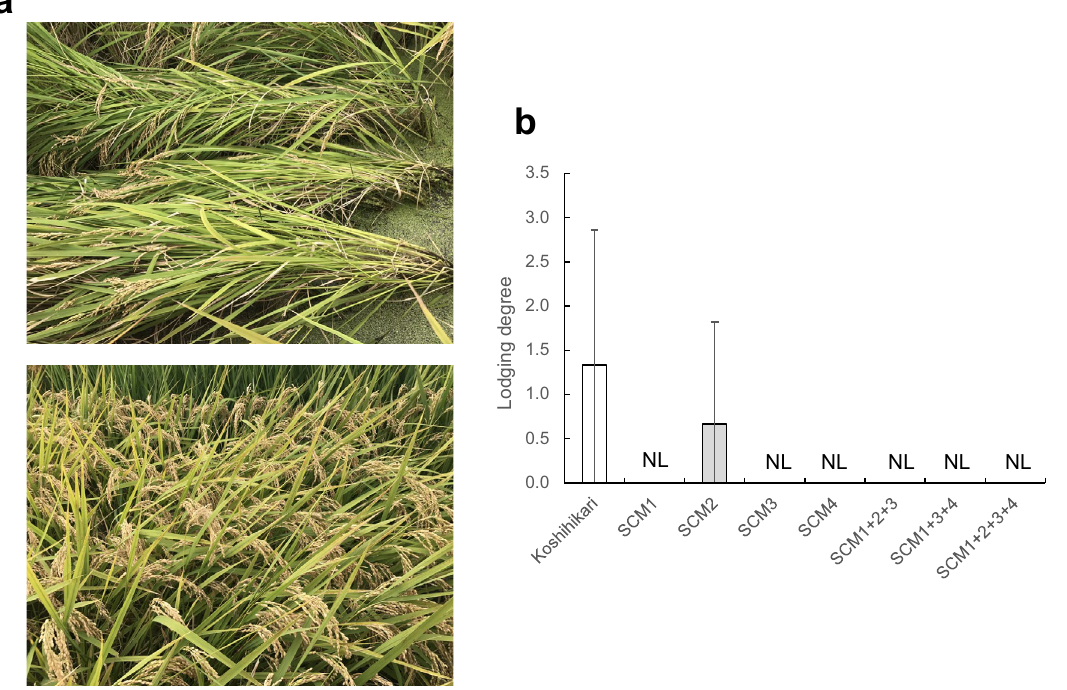
Figure 5. Evaluation of lodging resistance in paddy fields during harvest. ( a ) Representative photographs of Koshihikari (top) and SCM1 + 2 + 3 + 4 (bottom) at the 35 days after heading. ( b ) Degree of lodging. NL: No